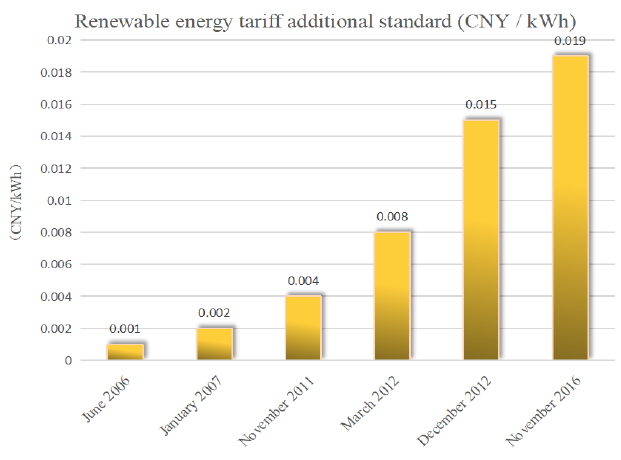
Figure 4. Renewable energy tariff additional standard from 2006 to 2016.